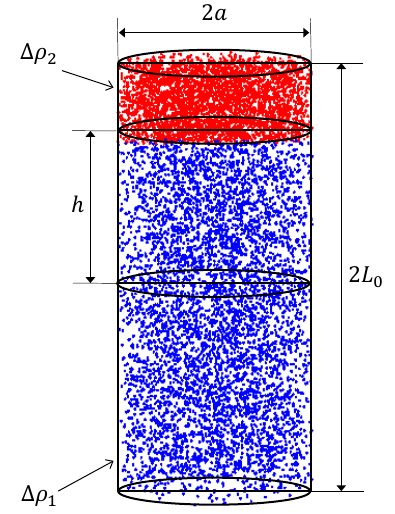
∆𝜌𝜌 1 Figure 3. (Color online) The model of a axially AnJPs with two regions of different sizes and different SLD. Here, a is the cylinder radius, 2 L 0 its height, and h is the height above the middle-plane. Region 1, red points; Region 2, red and blue points.